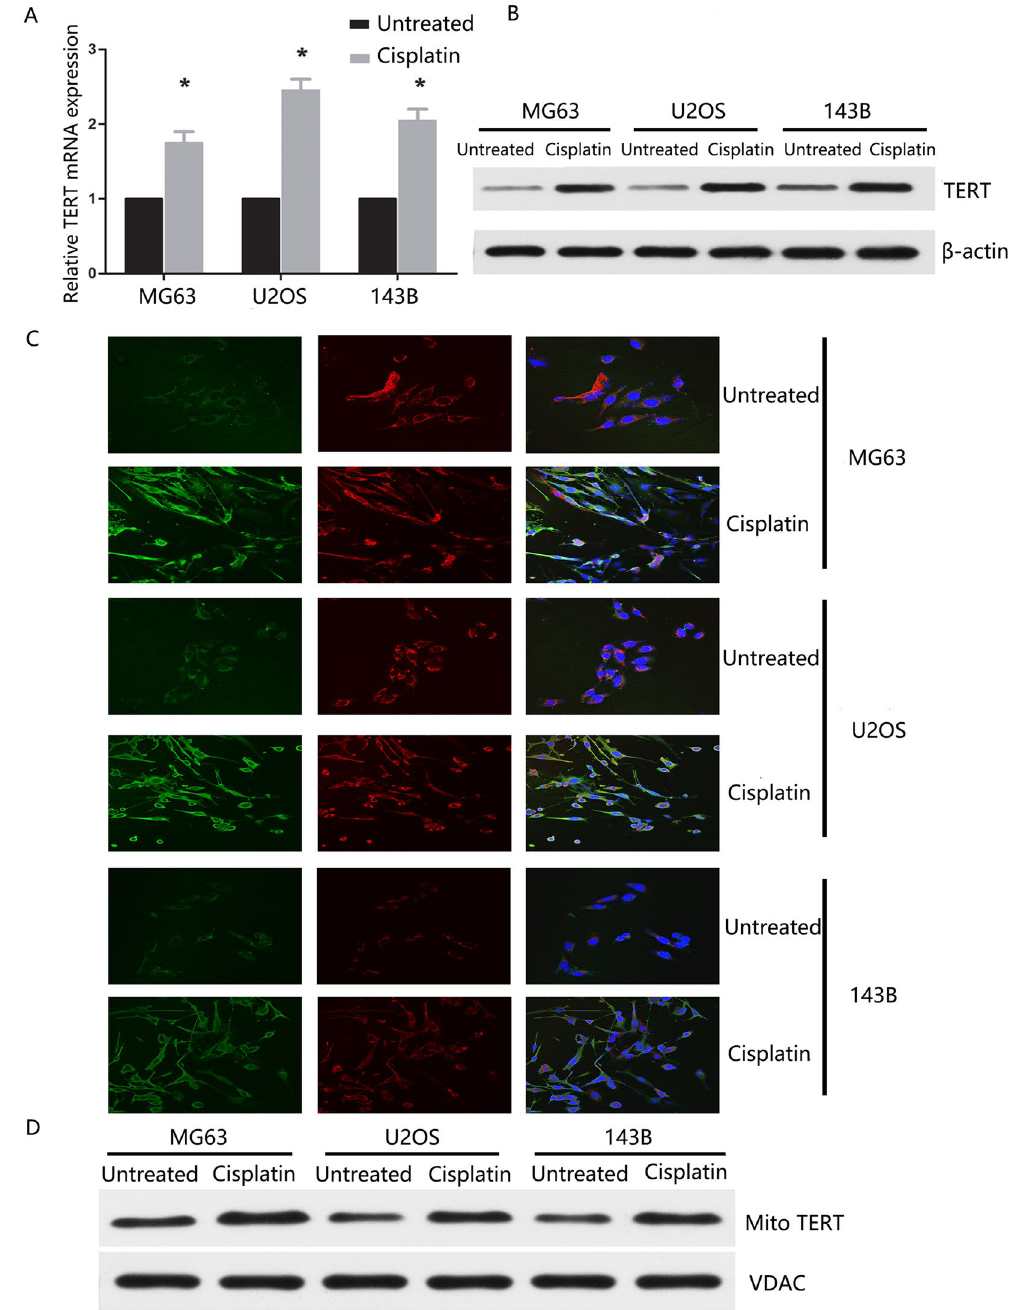
Figure 1. TERT expression is altered and shuttles from the nucleus to mitochondria in cisplatin-treated osteosarcoma cells. ( A ) The relative mRNA expression of TERT were determined by qRT-PCR in cisplatin treated or untreated osteosarcoma cells including MG63, U2OS and 143B. ( B ) The relative protein expression of TERT were analyzed by Western-blot in cisplatin treated or untreated osteosarcoma cell lines. ( C ) Confocal images from MG63, U2OS and 143B cells untreated (control, upper panel) or treated with 5 μ mol/L cisplatin for 24 h (lower panel). Green anti-TERT immune-fluorescence, red mitotracker and blue nuclear DNA (DAPI). Marked colocalization between green anti-TERT and red mitotracker is displayed by green-red mixing. ( D ) Mitochondrial fractions of cisplatin treated or untreated cells were subjected to Western blot analysis of TERT and VDAC. All experiments were carried out at least triplicates and the data were presented as the mean ± S.D. Student t test was performed to evaluate the difference * P <